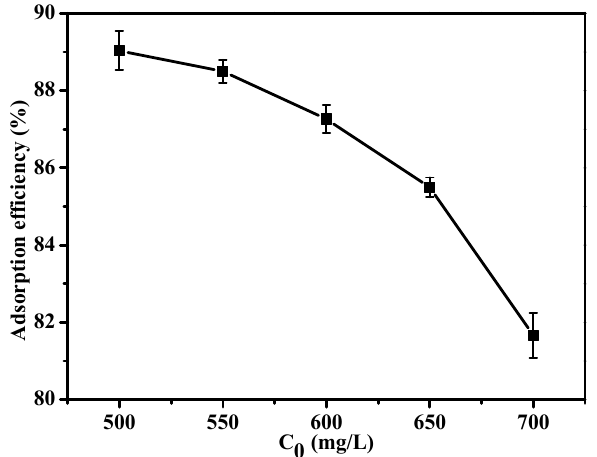
Figure 9. The adsorption efficiency of MSA-AC2 at different initial MB concentrations.